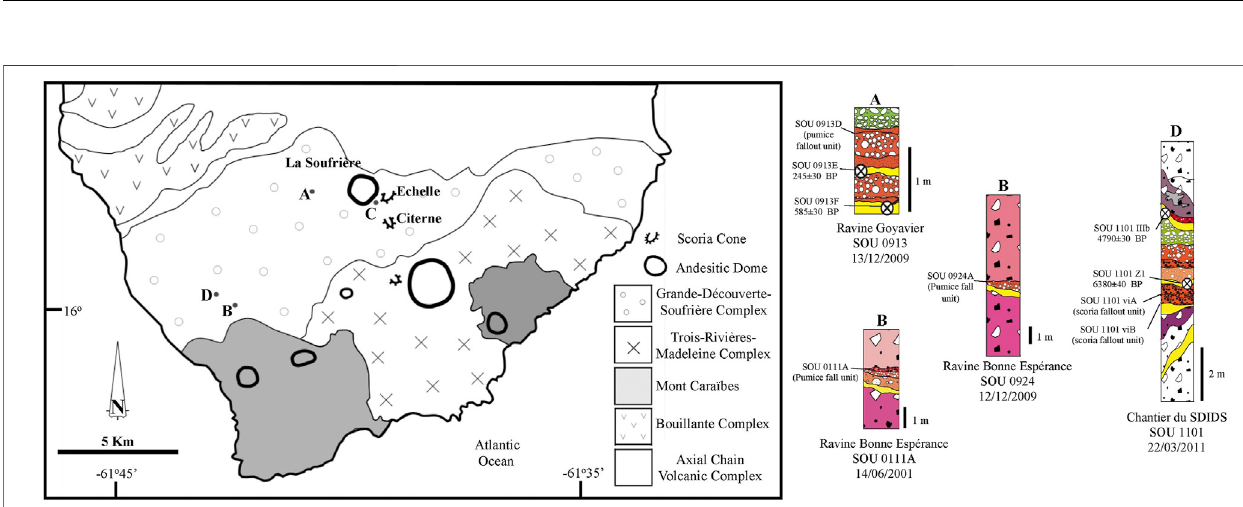
FIGURE 3 | Schematic map of the south of Basse-Terre, showing the main volcanic complexes present (Adapted from Komorowski et al., 2005). Sampling locationsaremarkedandcorrespondtothestratigraphiclogs,excludingthe ∼ 341Cal.CEeruption (C) .Amixofproximalanddistaloutcropsweresampled,depending on the quality and accessibility ofthe outcrop. Stratigraphic logs show the range oferupted products recorded at each location, in each case the sample used is labeled aswellasanydatedpalaeosolhorizons. (A) – 1657Cal.CE(SOU0913D)sampledfromafalloutunitfoundbetweenashlayersinRavineGoyavier.Thissamplewas foundaboveapalaeosolhorizondatedat245 ± 30yearsBP. (B) – 1010Cal.CE(SOU0111AandSOU0924A)sampledfrompumicefalloutunitsfoundinsequencesof ashandpumice fl owunitsinRavineBonneEspérance. (C) - ∼ 341Cal.CE(SOU1904A)wassampledfromaslumpofftheEchellemonogeneticcone,sonostratigraphic position is available. (D) – 5680 Cal. BCE (SOU 1101viA) sampled from a scoria fall out unit in a sequence of pumice and scoria fallout units at Chantier du SDIDS. This sample was taken from directly below a palaeosol horizon dated at 6380 ± 40 years BP. [Adapted from Komorowski et al. (2005) and Legendre (2012)].